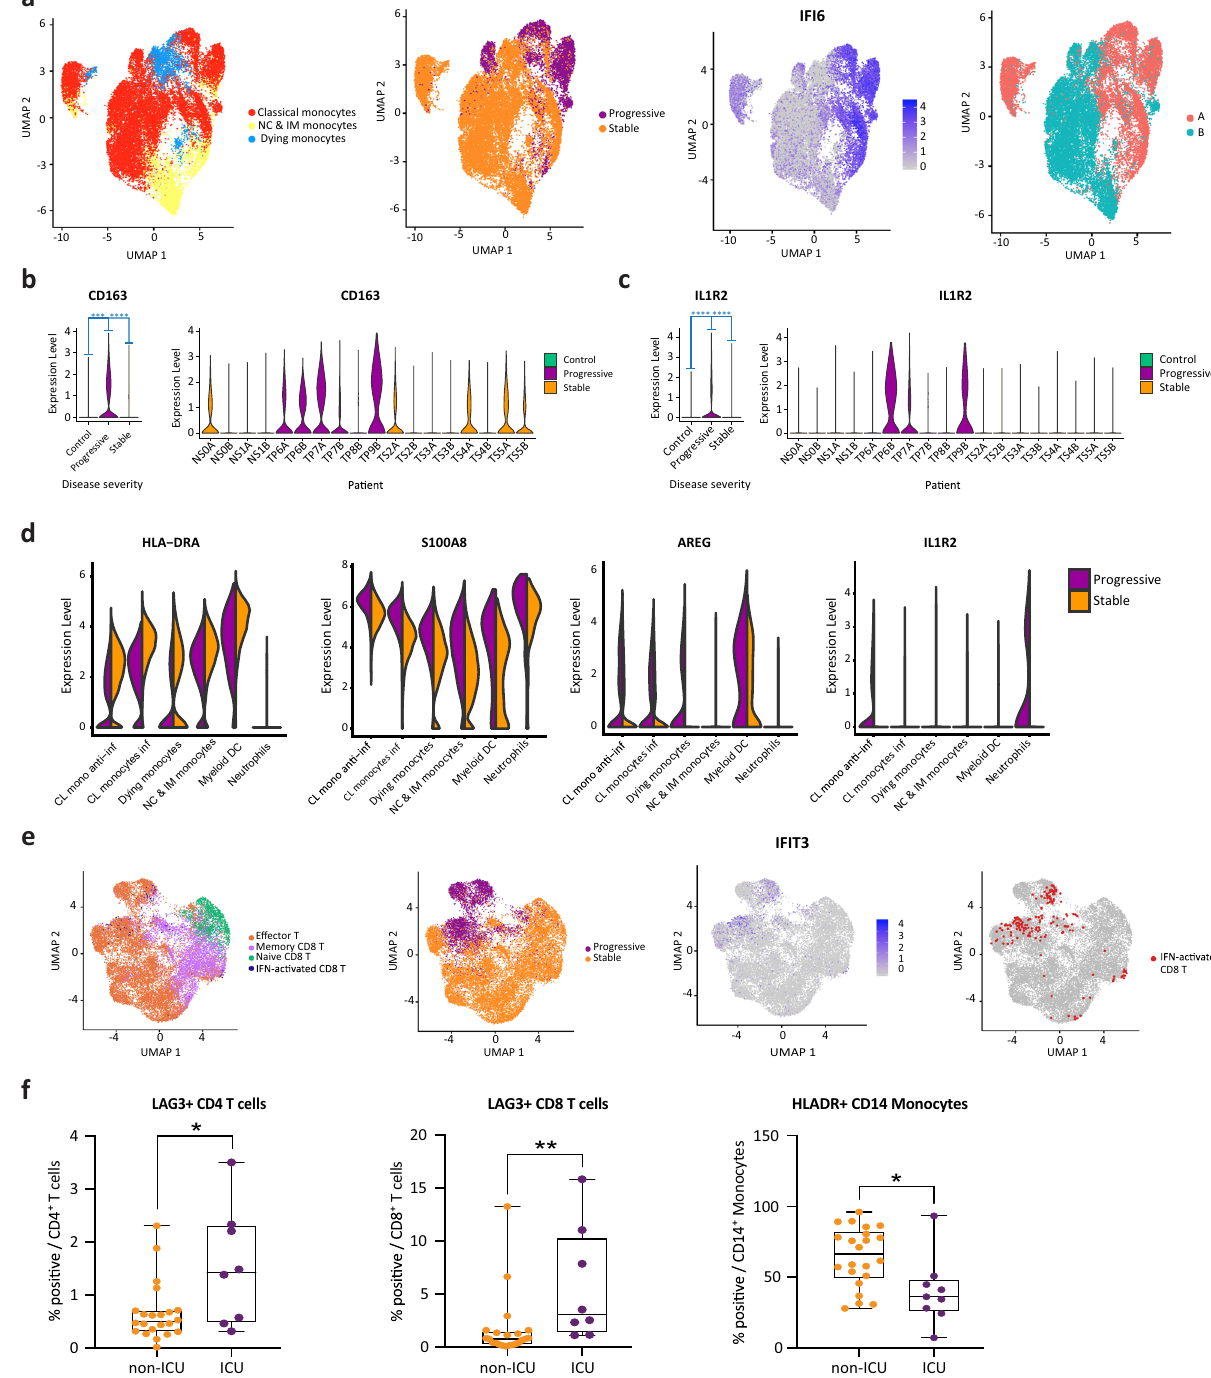
Surface protein-based immune-phenotyping of peripheral clustering, annotation for CITE-seq cells was performed with blood cells in COVID-19 . We next constructed an independent both gene expression and antibody-derived counts (ADT) by immunophenotypic map of PBMCs using CITE-seq 18 . To better using a manually curated marker gene list (Supplementary identify cellular multiplets and enable us to super-load the cells Data 7). We observed a cluster of unde fi ned cells ( n = 8032) that onto the 10× platform, we used Cell Hashing technique and are positive for multiple linage markers of ADT signals and/or multiplexed 5-6 samples in each 10× reaction. We adopted 189 display elevated signals unlikely to be explained by immunolo- oligonucleotide-labeled antibodies (Total seq C antibody panel gical evidence. Those cells were removed from the analysis, and from BioLegend) (Supplementary Data 5). Multiplets and cells all other cells were plotted on UMAP space (Supplementary with unidenti fi able sample origin were removed from the Fig. 14a). In order to investigate the coherence of both annota- downstream analysis and 83.2% of the cells were analyzed tions, we calculated the percentage of shared cells between RNA ( n = 43,349; Supplementary Data 6). Following unsupervised and ADT-annotated cell types (Supplementary Fig. 14b). NATURE COMMUNICATIONS| (2022) 13:440